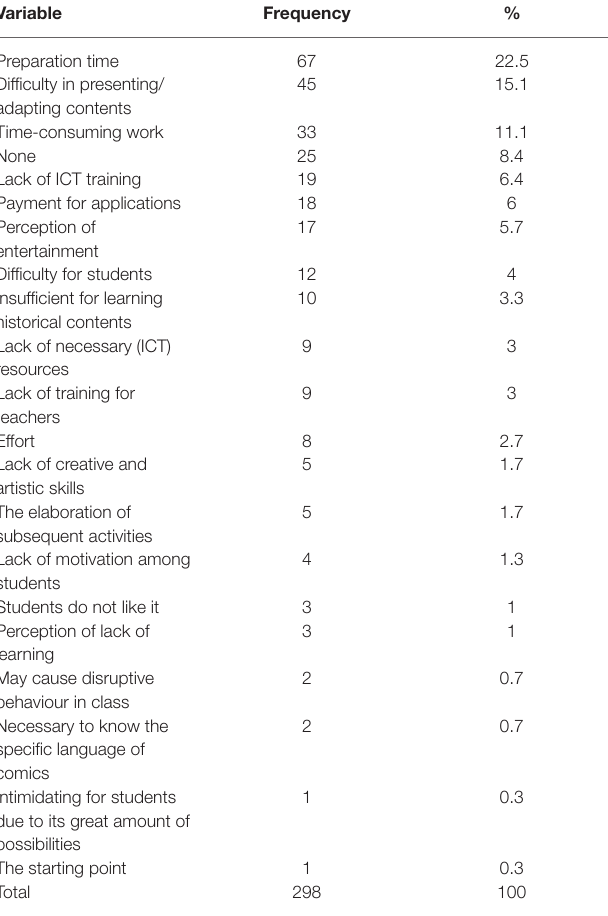
TABLE 12 | Negative aspects regarding the use of comics as a resource for learning history.